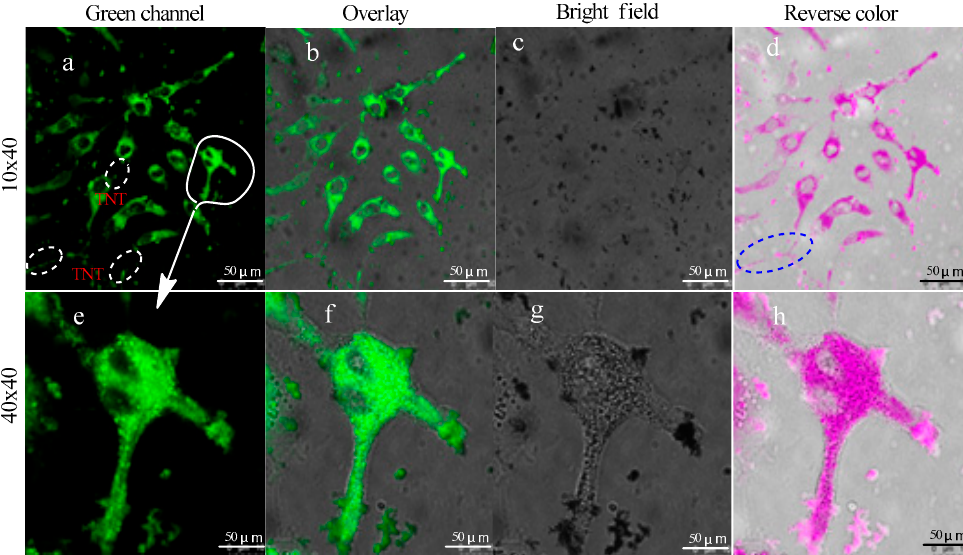
Figure 8. Confocal imaging of HEC-1A cells incubated with ESIPT-F for 30 min. ( a – d ): Confocal imaging of the HEC-1A cells incubated with ESIPT-F and observed at 10 × 10 magnifications, respectively; ( e – h ): Live-cell imaging of the same HEC-1A cells acquired at 40 × 40 magnifications. HEC-1A cells were incubated in a DMEM medium containing 30 µ M ESIfiPT-F for 1.0 h. After washing with PBS (pH 7.4), the live cell imaging was achieved using a confocal microscope, showing the tunneling nanotubes of the resulting cells. λ ex = 405 nm, λ em = 500–550 nm, bar = 50 μ m.